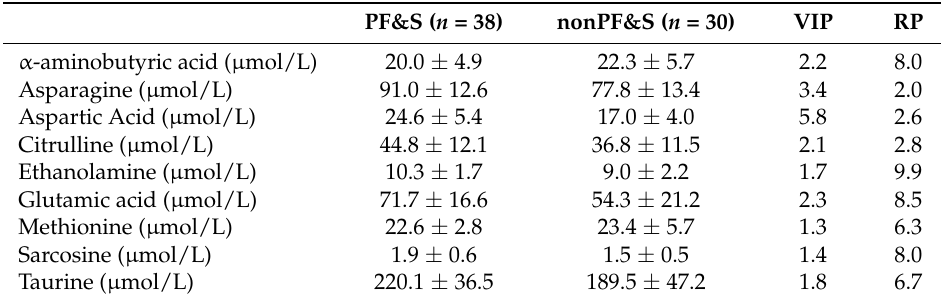
Table 2. Serum concentrations of discriminant analytes, variable importance in projection (VIP) values, and rank product (RP) values in BIOSPHERE participants with and without physical frailty and sarcopenia (PF&S). Serum concentrations are shown as mean ± standard